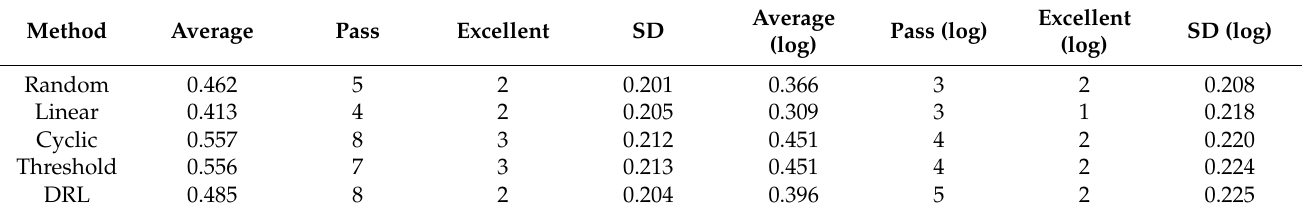
Table 2. The results of EFC that do not consider the knowledge point association.